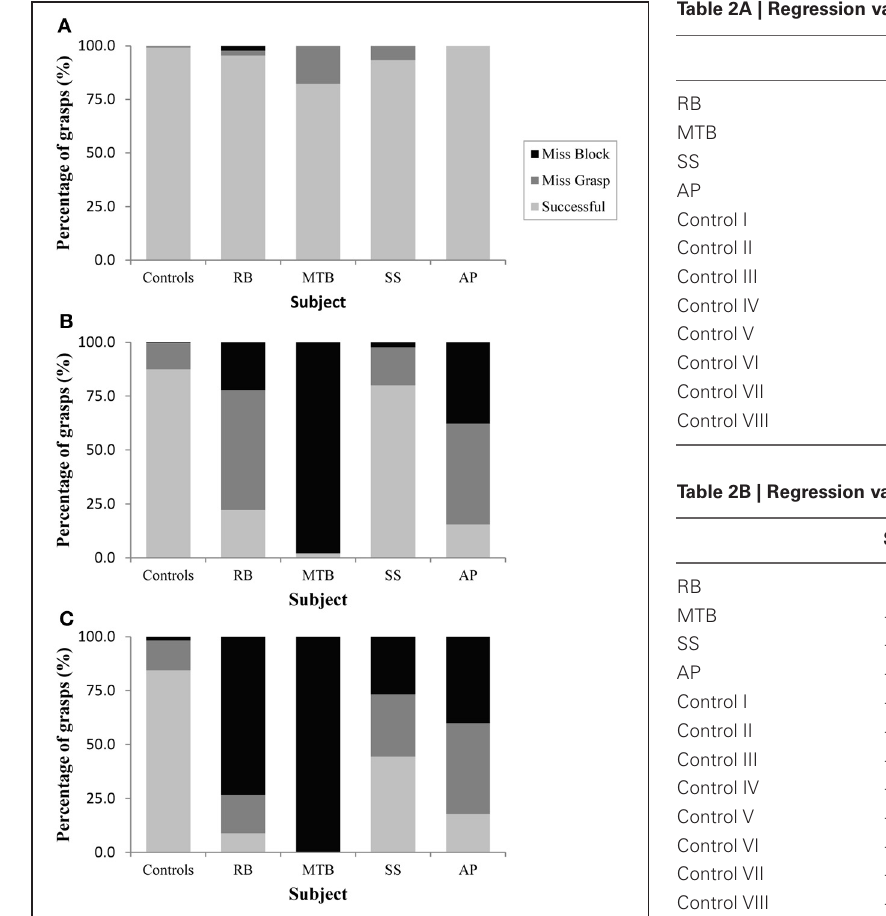
FIGURE 2 | Grasping precision in Experiment 1 for (A): the closed-loop condition, (B): the immediate open-loop condition, and (C): the delayed open-loop condition.